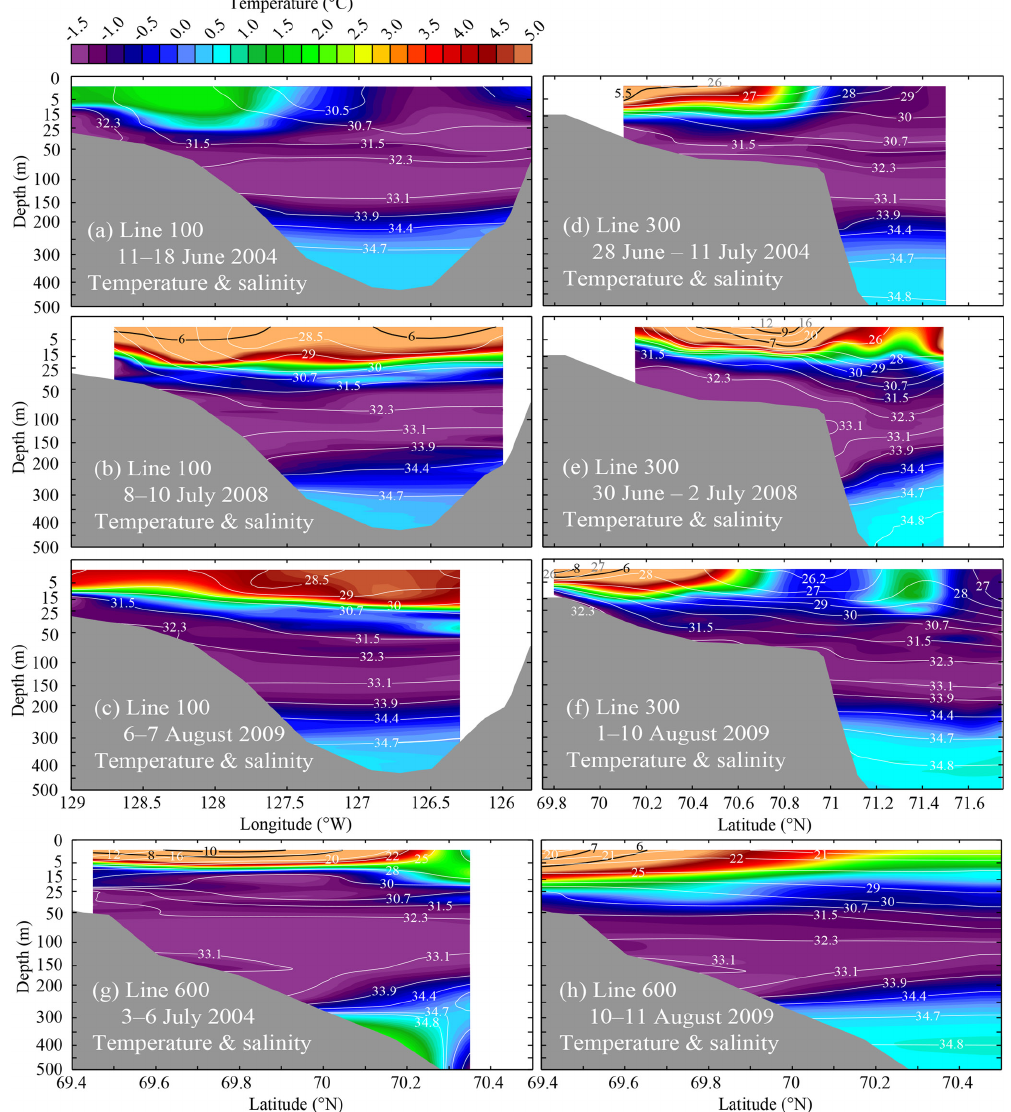
Figure 8. As Fig. 7 but for measurements of water temperature (colors) and salinity (contour